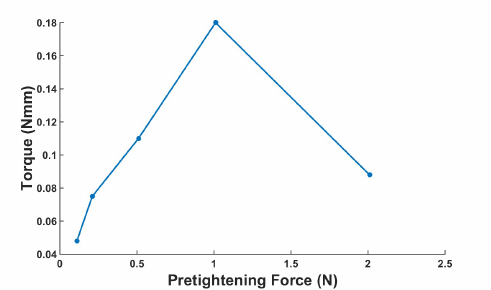
Figure 19. Maximum output torque under different pretightening forces.